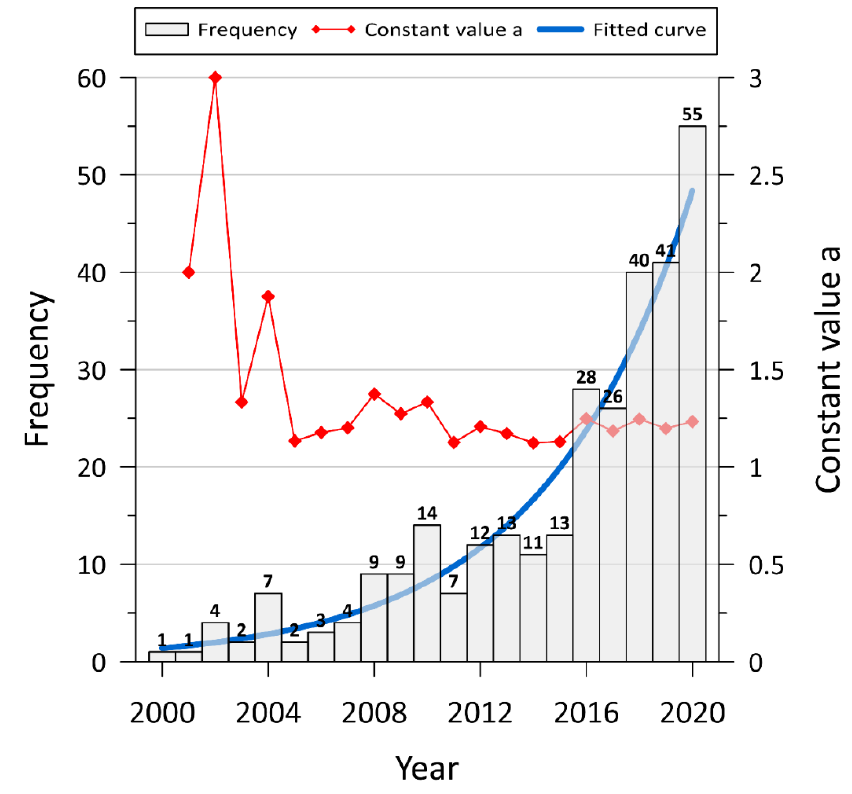
Figure 2. Annual frequency distribution of LAC flood-related articles published in WoS-registered journals.